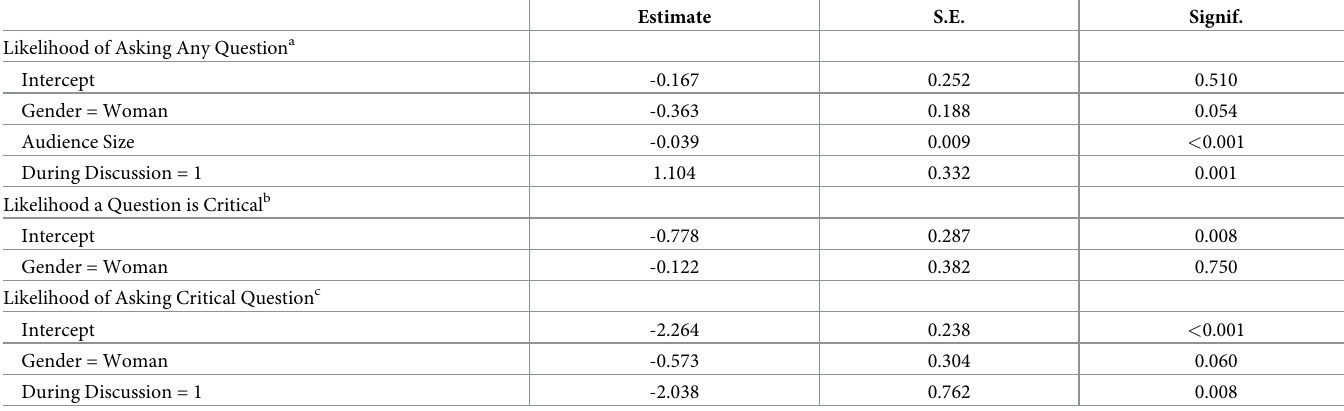
Table 2. Results of mixed logistic models testing for general gender effects.